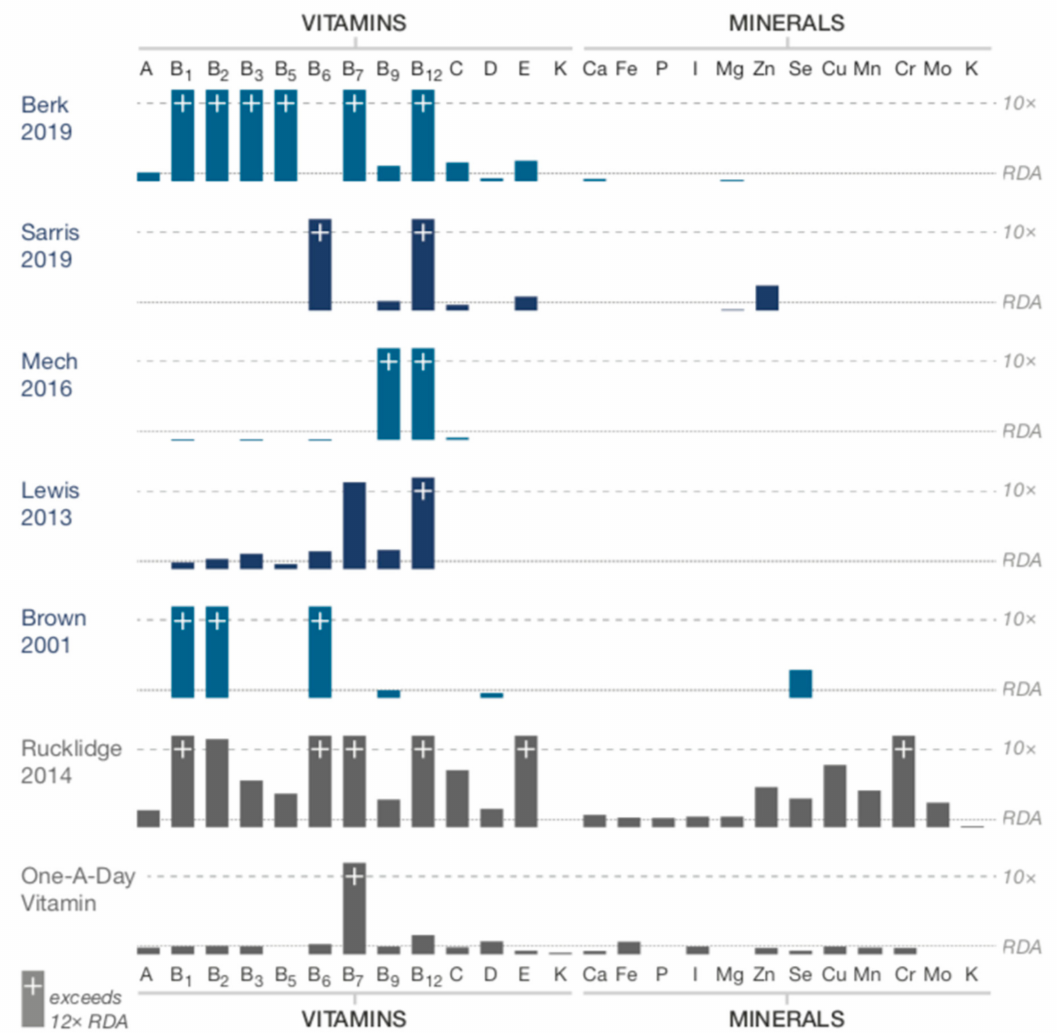
Figure 4. Comparing ingredient dosages in studies of participants with depression, including One-A-Day ® , an over-the-counter formula for